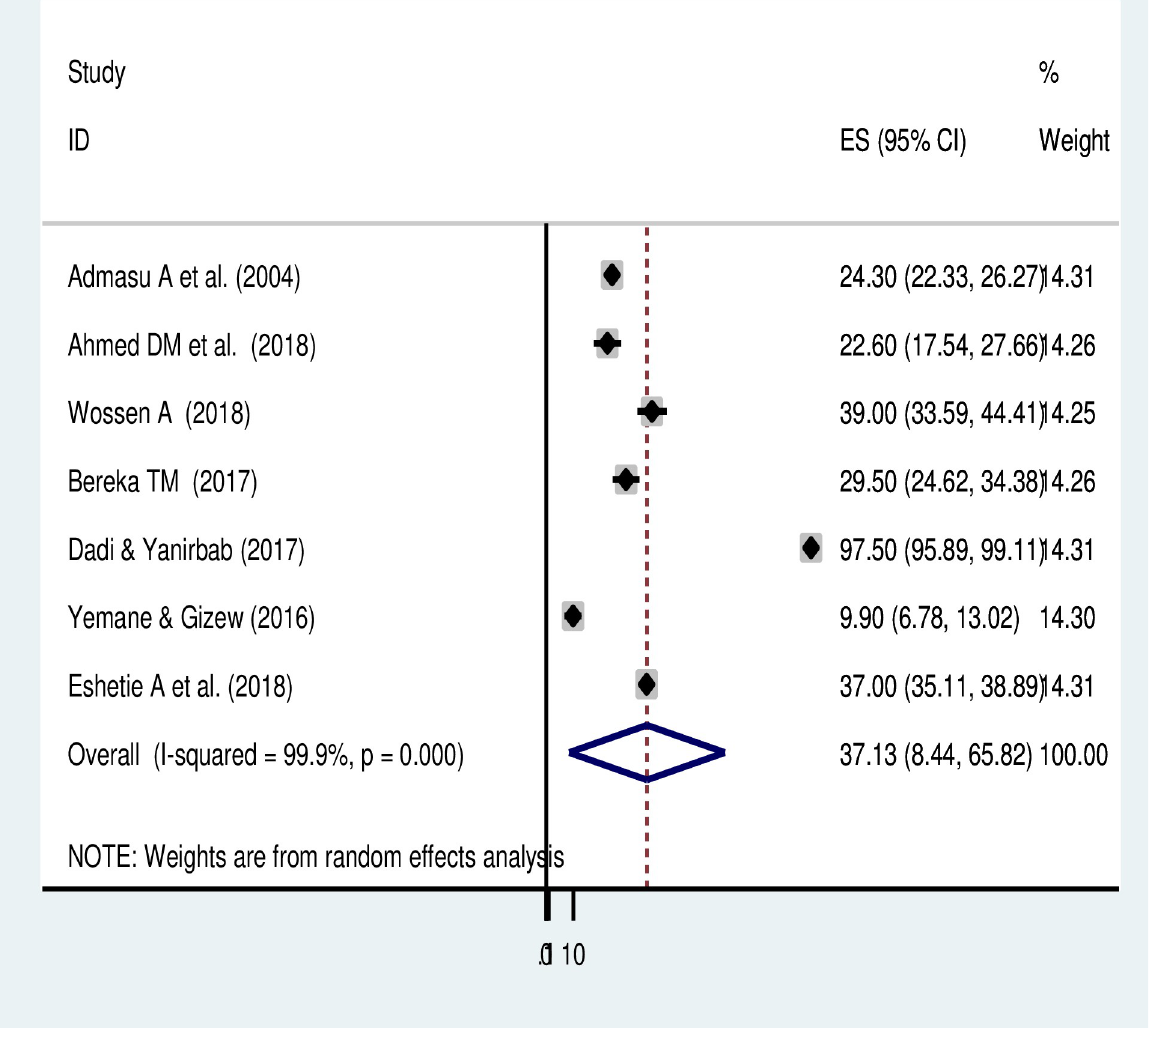
Fig 4. Pooled prevalence of maternal morbidities of uterine rupture in